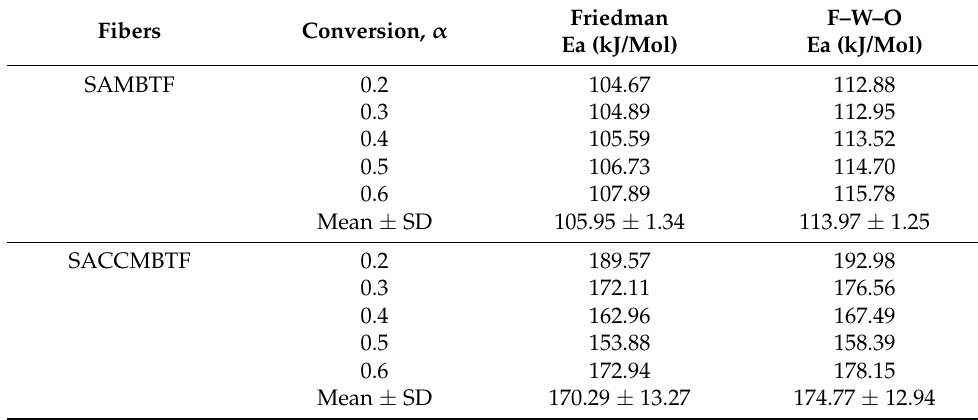
Figure 1. Plots of the thermogravimetric analysis: ( a ) TGA and ( b ) DTG curves of BTF, MDBTF, SACCMDBTF and SAMDBTF. Table 2. Average activation energy of SAMDBTF and SACCMDBTF calculated by the Friedman and Flynn–Wall–Ozawa methods at a period of α =